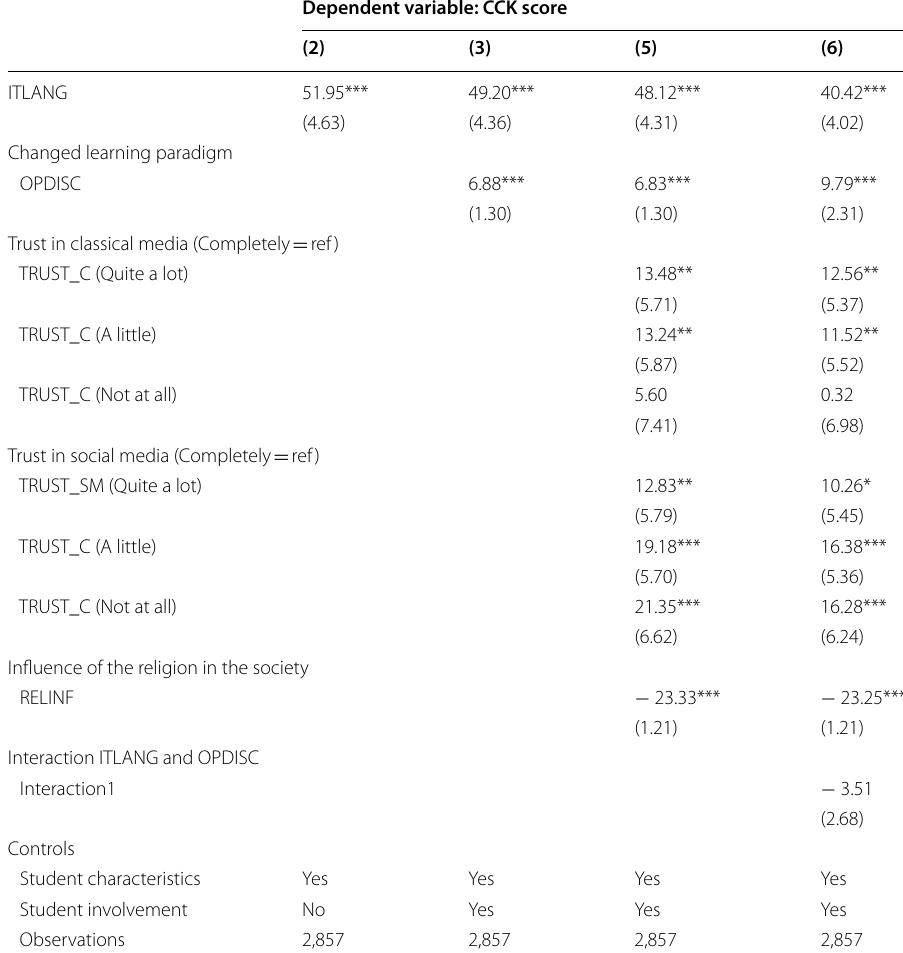
Table 3 Random effects estimates in hierarchical